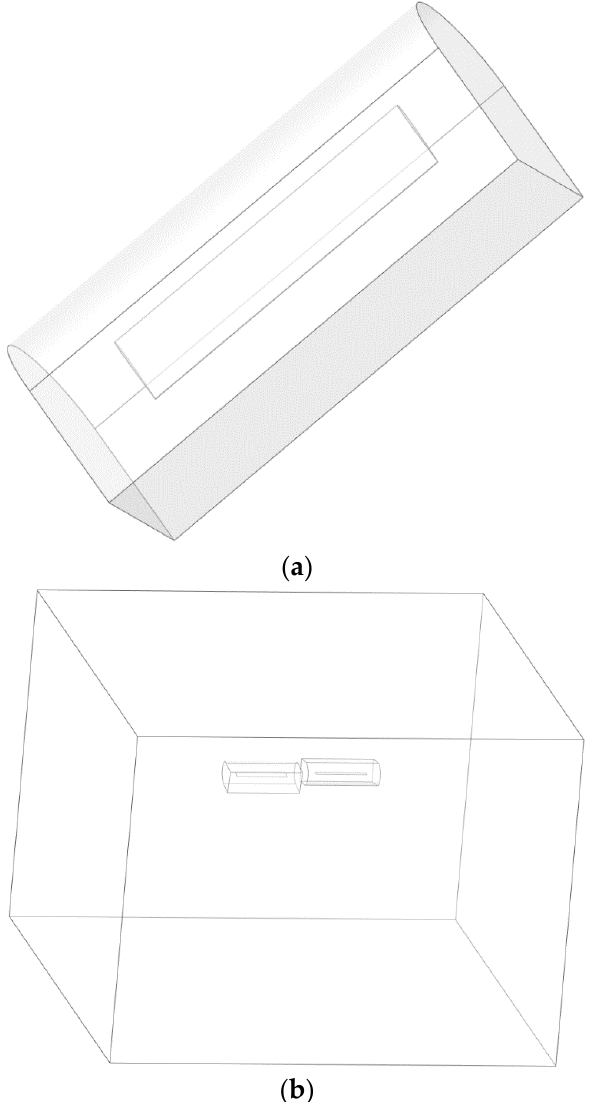
Figure 1. The nested system model. ( a ) The foreground area surrounding the blades. ( b ) Assembly drawing of the foreground area and background area.